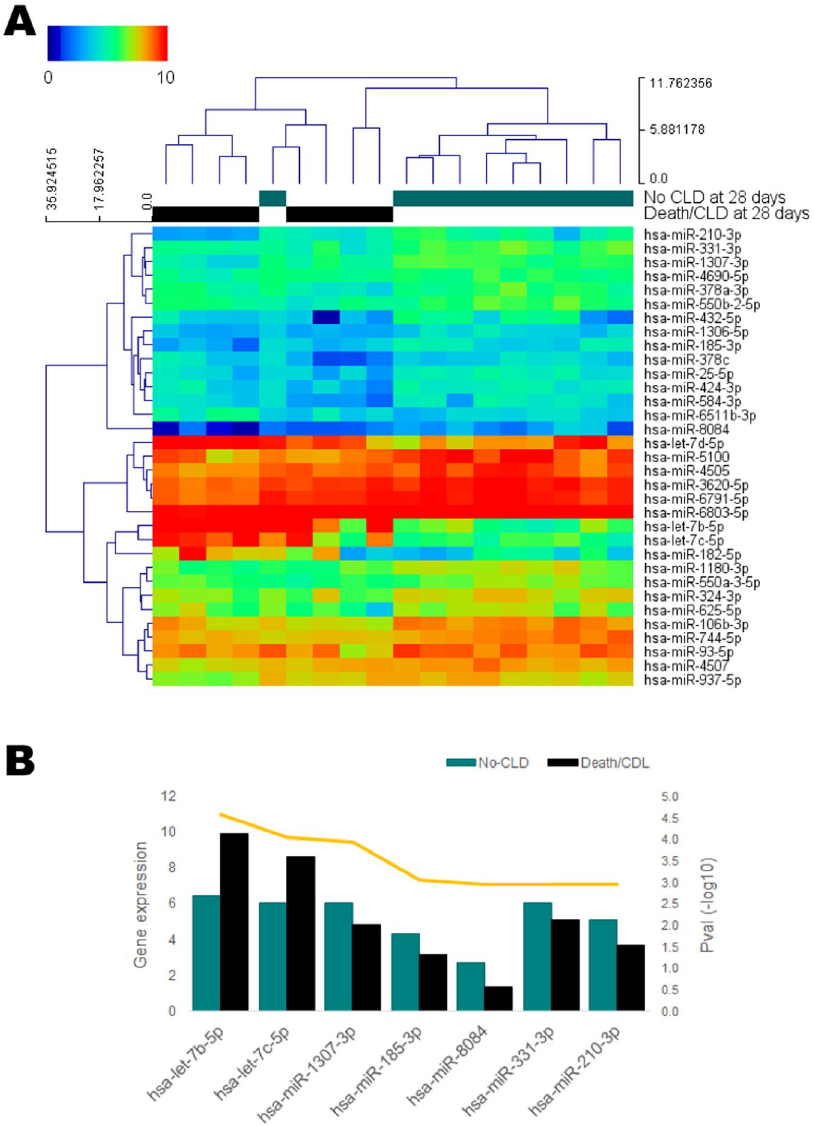
Figure 1. ( A ) Heatmap of significantly changed circulating mature miRNAs in CDH-PH children who died or developed CLD during the first 28 days after birth (Death/CLD at 28 days, n = 8), compared to those children who survived without developing CLD during this period (No-CLD at 28 days, n = 10). Blood samples were drawn 24 h after birth. Statistical significance was obtained through a moderated t-test (unadjusted p < 0.05). Hierarchical clustering was applied to samples and miRNAs using Euclidean distances with complete linkage. (B) Expression levels of those differentially expressed miRNAs (Benjamini-Hochberg-adjusted p < 0.05 and expression change ≥ 1) in the Death/CLD and No-CLD groups of CDH children. P-values are represented by the yellow